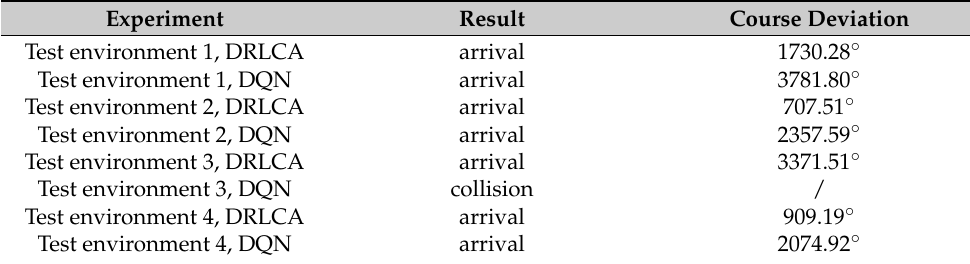
Table 4. Results of four experiments.